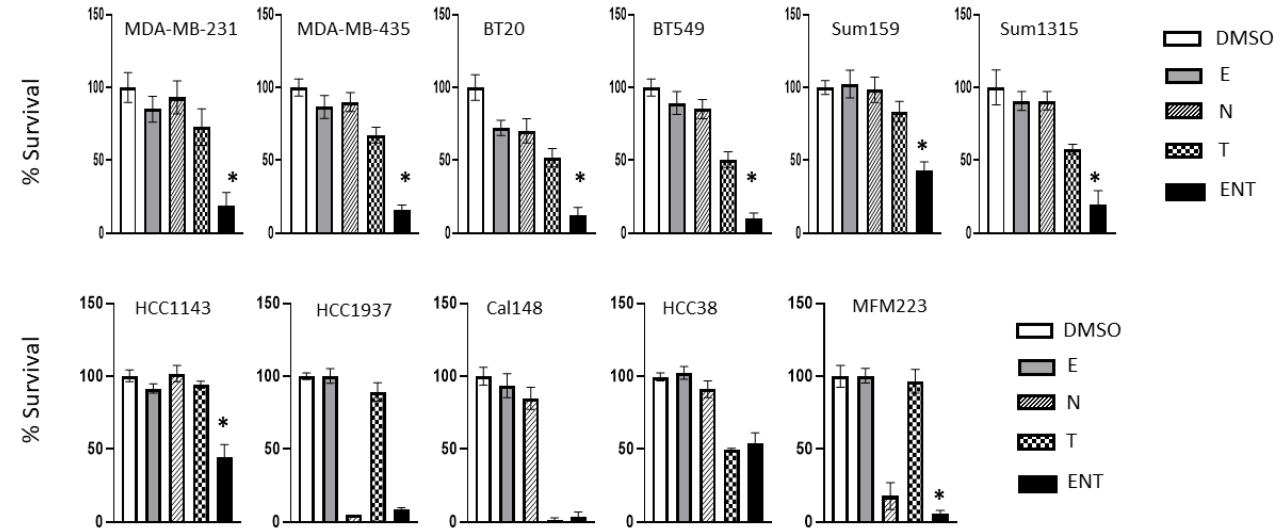
Figure 2. Triple-negative breast carcinoma; the combination of HDAC-i Entinostat (E), Niclosamide (N), and HSP90-i Tanespimycin (T). The TNBC cell lines BT549, BT20, HCC38, CAL148, HCC 1143, HCC 1913, MDA-MB-231, MDA-MB-435, MFM223, Sum159, and Sum1315 are treated with Entinostat (E: 100 nM), Niclosamide (N: 100 nM), and Tanespimycin (T: 50 nM) alone and in combination (ENT) in 96-well plates for 7 days with indicated drugs. The inhibition of cell proliferation by E, N, T, and ENT is measured by WST assay. The relative cell number is calculated compared to vehicle control (DMSO) and expressed as mean ± SD ( n = 6) of percent viability. (*) Inhibition in cell proliferation is greater than expected by additivity. See Supplementary Table S1 for details.